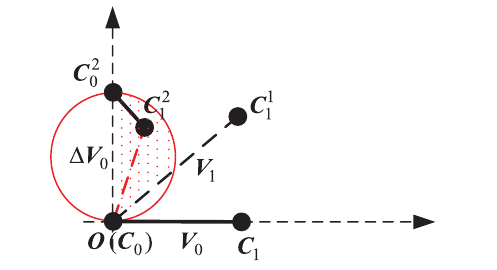
Fig. 7 Determine the third control vector.